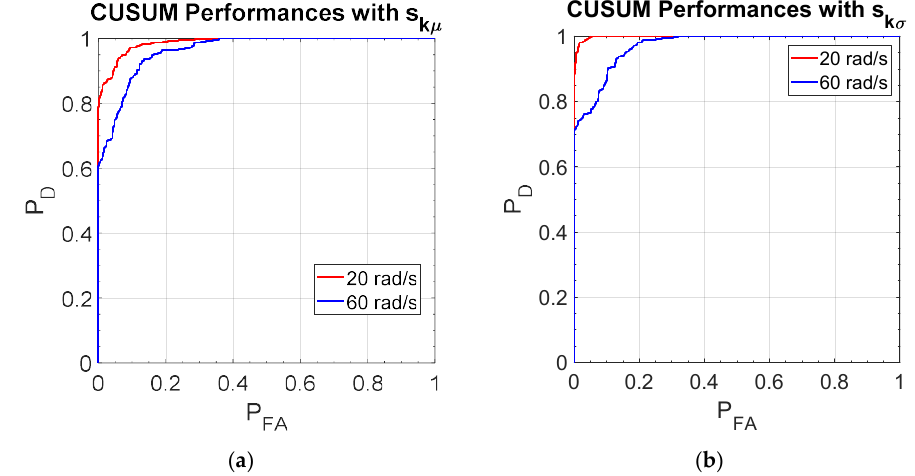
Figure 14. 100 µ s OSF detection performance for SNR = 20dB and 50% of the load: ( a ) With mean value, ( b ) With variance.